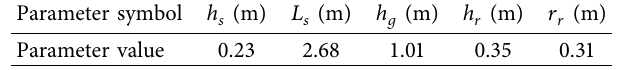
Figure 10: Simulation process of vehicle crossing trench. (a) 2.7m trench. (b) 2.75m trench. Table 8: Key parameters of a vehicle crossing a vertical